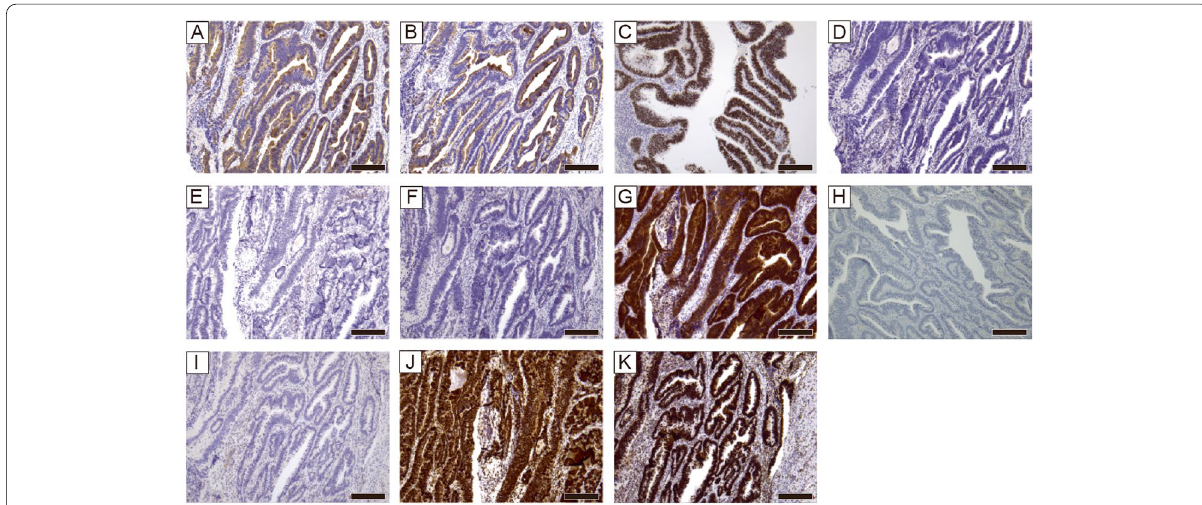
Fig. 3 Pathological findings of immunohistochemistry. A Cytokeratin 20. Magnification: 100 100 , scale bar: 200 µm. C . CDX2. Magnification: 100 × Progesterone receptor. Magnification: 100